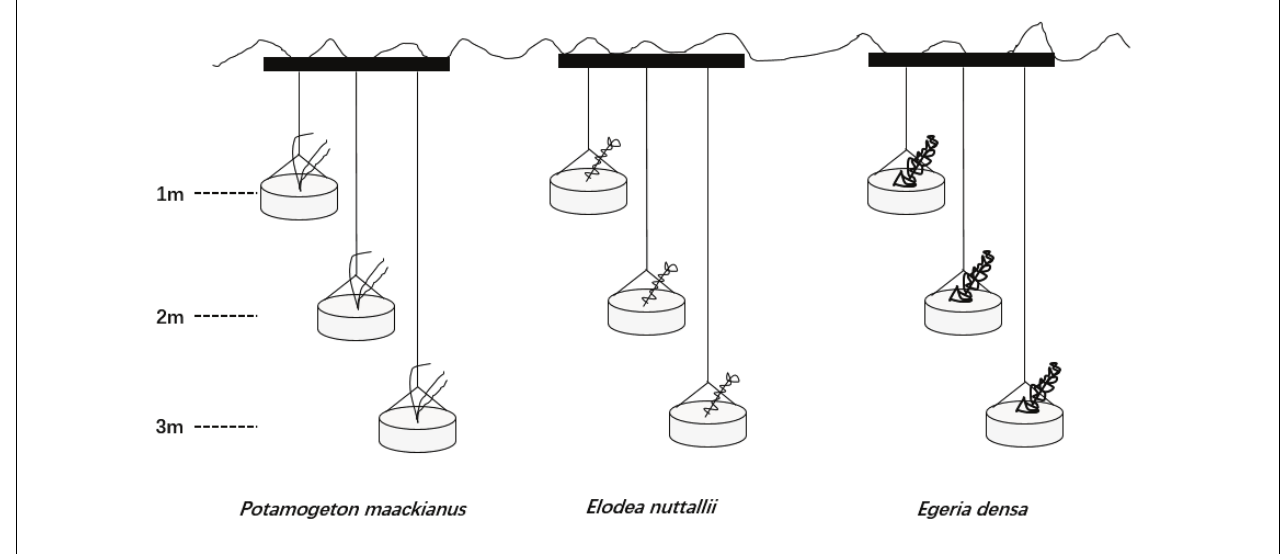
FIGURE 1 | Design of the experiments showing three of the 9 containers in which the three species were